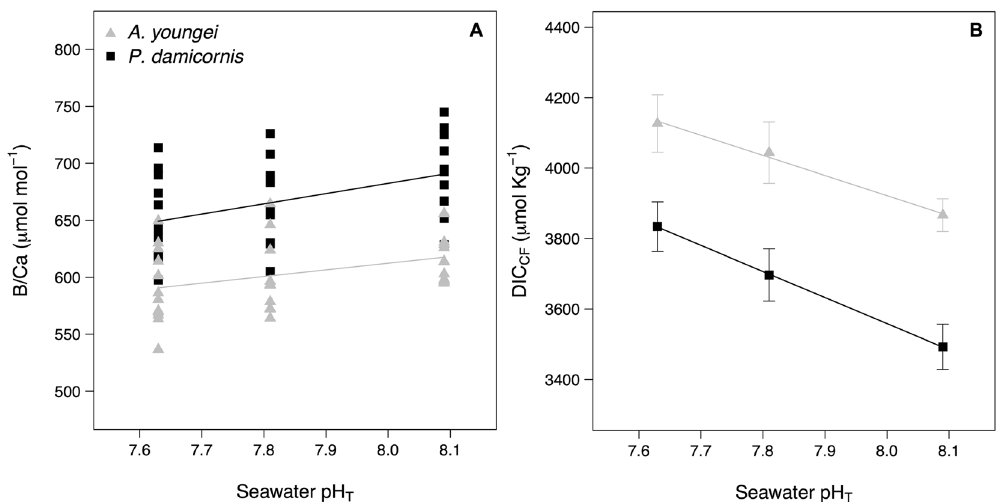
Figure 3. Measured B/Ca ratios ( A ) and DIC in the calcifying fluid (DIC cf ) estimates ( B ) for the corals Acropora youngei (grey triangles) and Pocillopora damicornis (black dots). Measurements and estimates were made on corals incubated at pH = 8.09, 7.81, and 7.63 during 8 weeks. Values for the B/Ca ratios are individual measurements and displayed DIC cf are mean ± SE (n = 12). Uncertainty on DIC cf estimates was 110 μ mol. Kg − 1